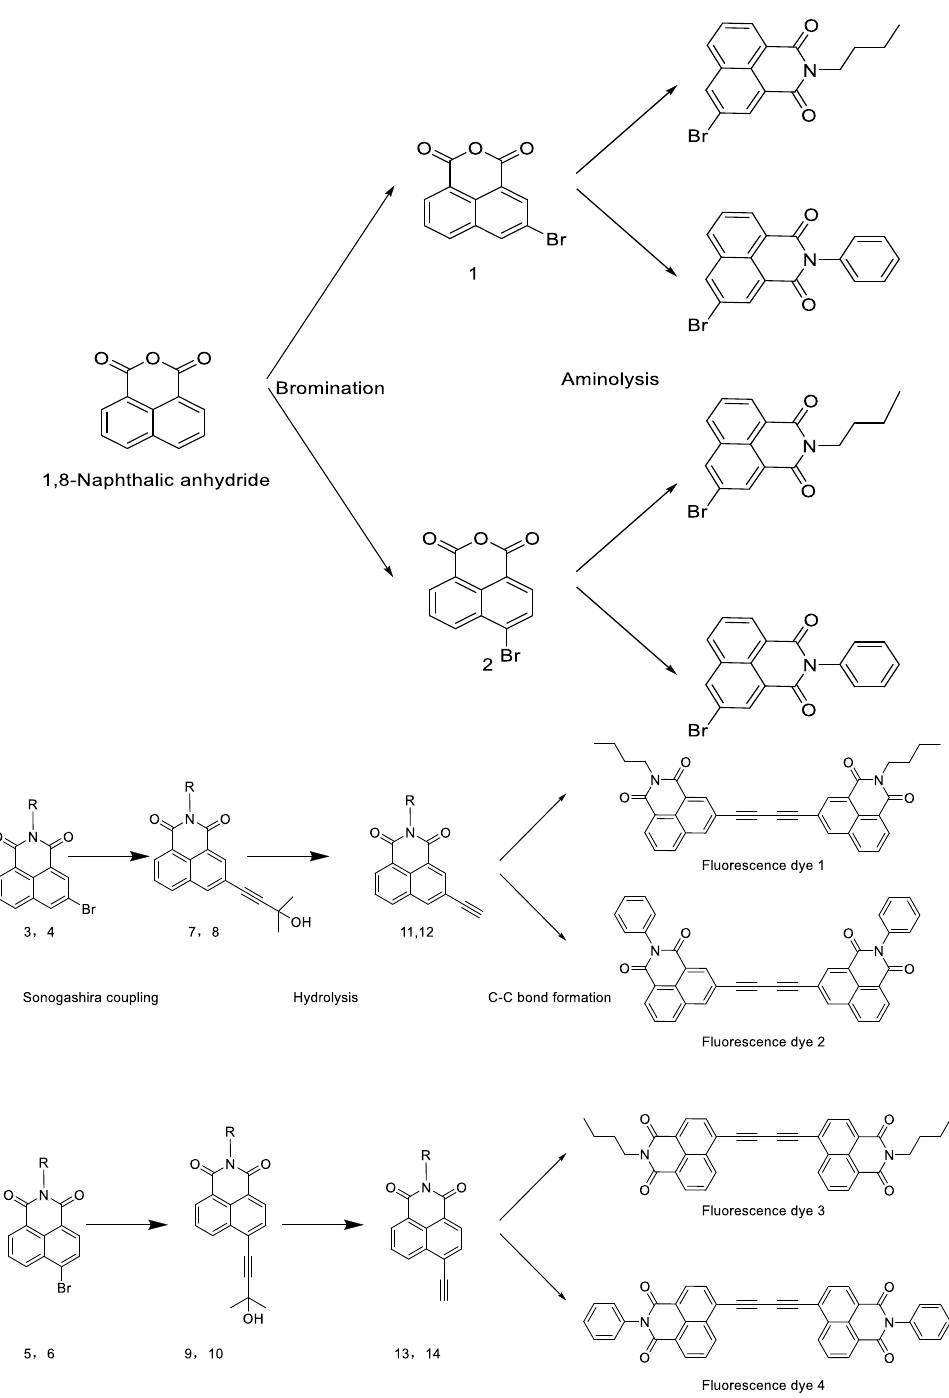
Figure 2. Synthesis routes of fluorescence dyes 1–4. Adapted with permission from ref. [22]. Copyright 2018 Science Direct.